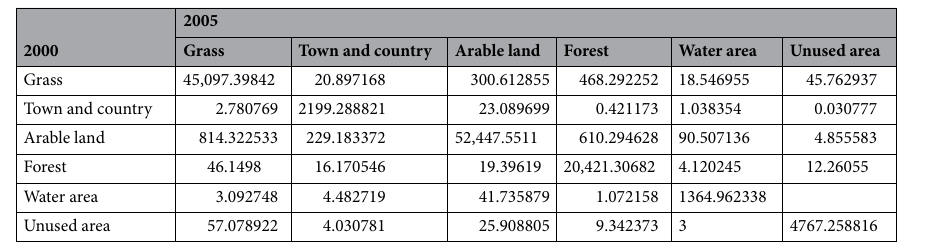
Table 5. Transfer matrix of land use types in the study area from 2000 to 2005 (km 2